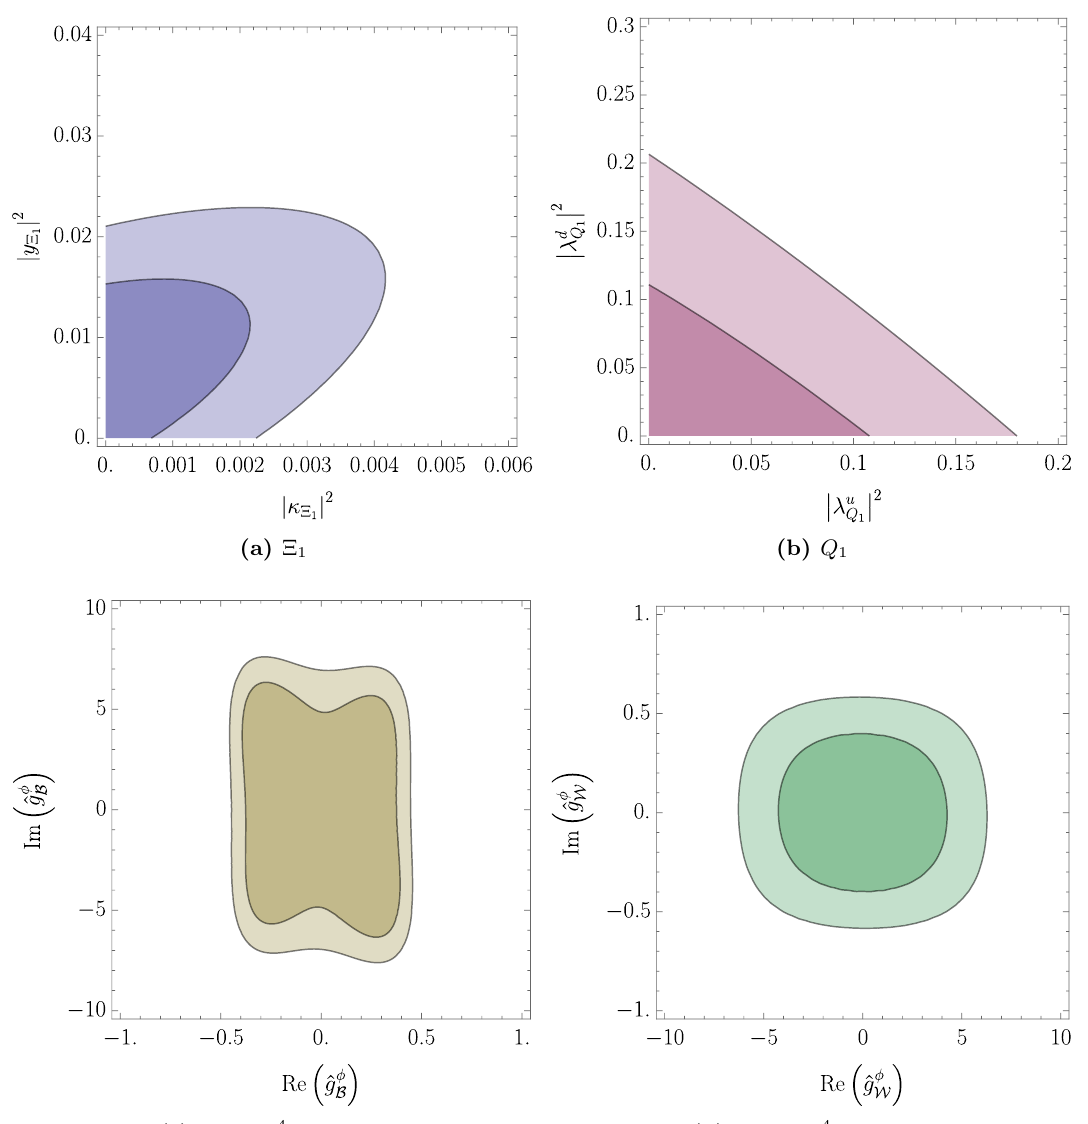
Figure 6. The viable parameter spaces in the renormalizable (cid:4) 1 , Q 1 , B , and W models de(cid:12)ned in table 6, assuming a mass of 1 TeV. For the two latter models we have assumed all four-fermion oper- ators are zero. The regions shaded in darker and lighter colours are allowed at 1 and 2 (cid:27) ,